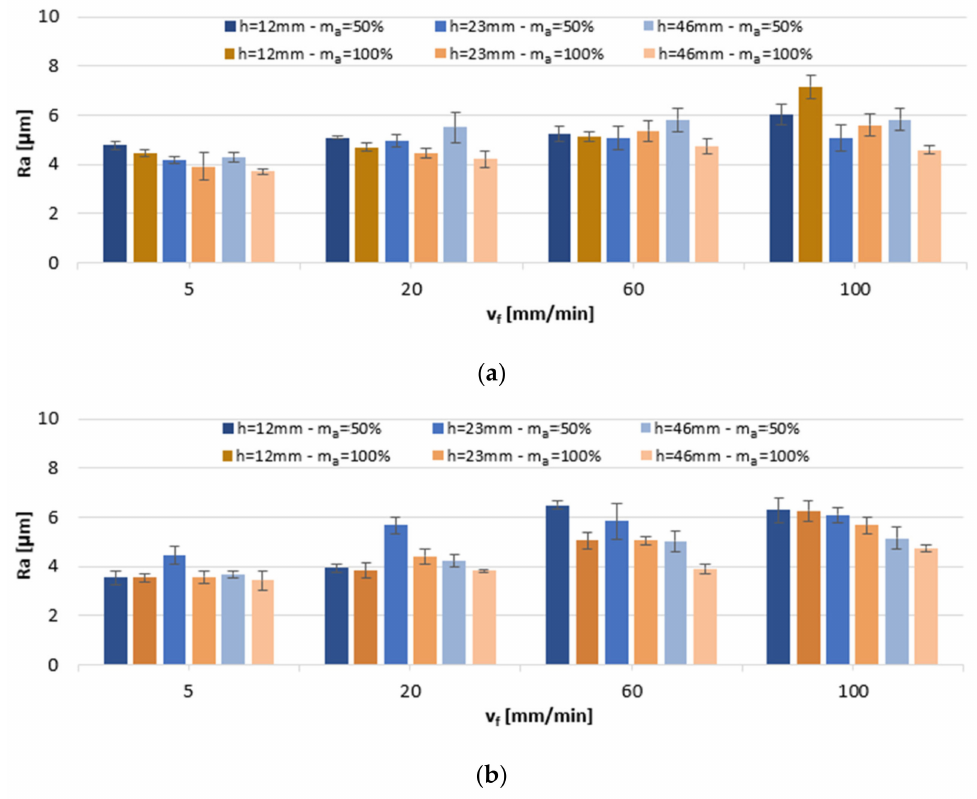
Figure 2. The impact of jet feed rate v f , sample height h, and abrasive flow rate m a on Ra of post-machined alloys: ( a ) AlSi10Mg and ( b )